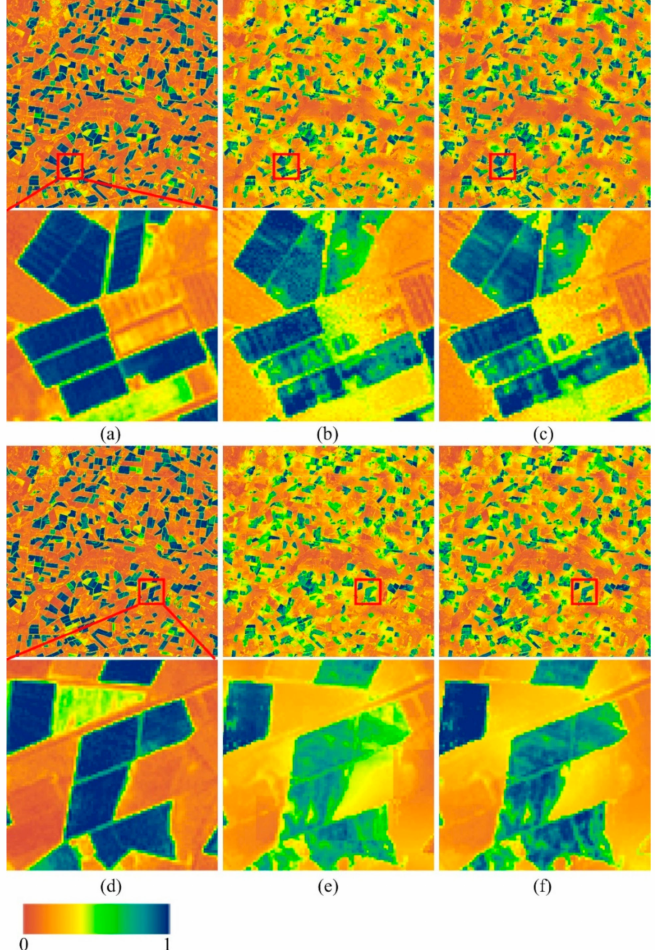
Figure 7. Landsat NDVI of the Coleambally Irrigation Area on 12 January 2002: ( a , d ) actual images for two test areas, ( b ) image predicted by FSDAF, ( c ) image predicted by bias-corrected FSDAF, ( e ) image predicted by the STARFM, and ( f ) image predicted by the bias-corrected STARFM. For the whole image, the fusion results of FSDAF obtained after correction were highly correlated with the actual NDVI (CC = 0.8269 and RMSE = 0.1449). The increases in structural similarity (SSIM) reduced the blur caused by pixel discontinuities. For the STARFM, the bias-corrected inputs of the fusion results showed a higher CC (0.8406), lower RMSE (0.1416), and higher SSIM (0.7186). Compared to the actual Landsat NDVI, the low AD values were 0.0002 and − 0.0056, indicating the high accuracy of NDVI fusion by FSDAF and the STARFM after bias